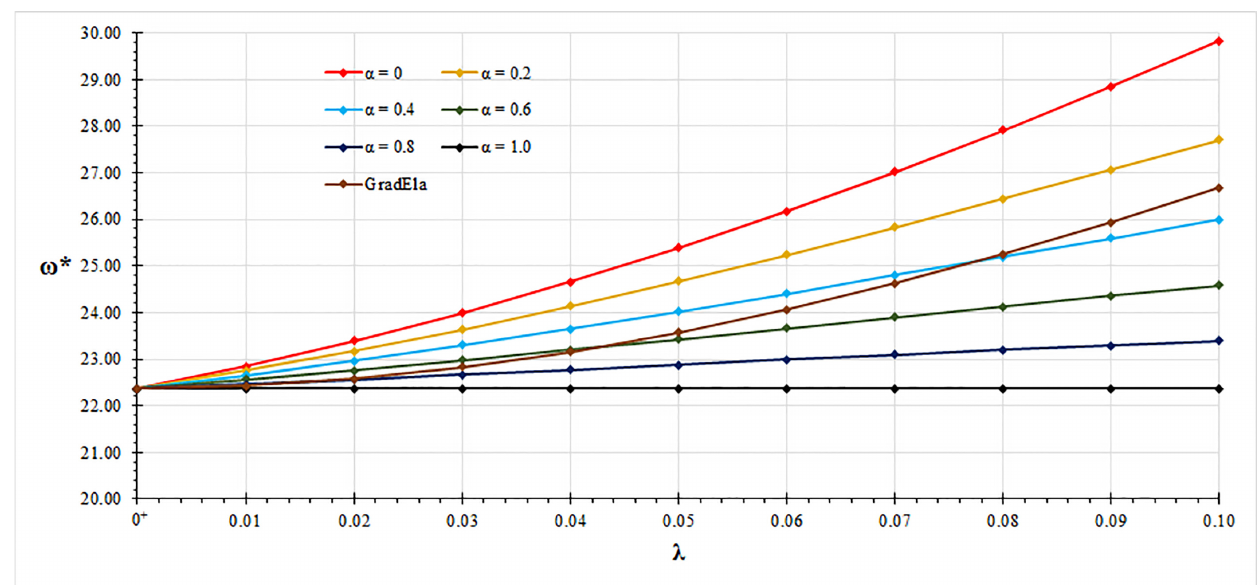
Figure 5. Clamped-clamped beam: non-dimensional fundamental natural frequency ω ∗ vs. nonlocal parameter λ for